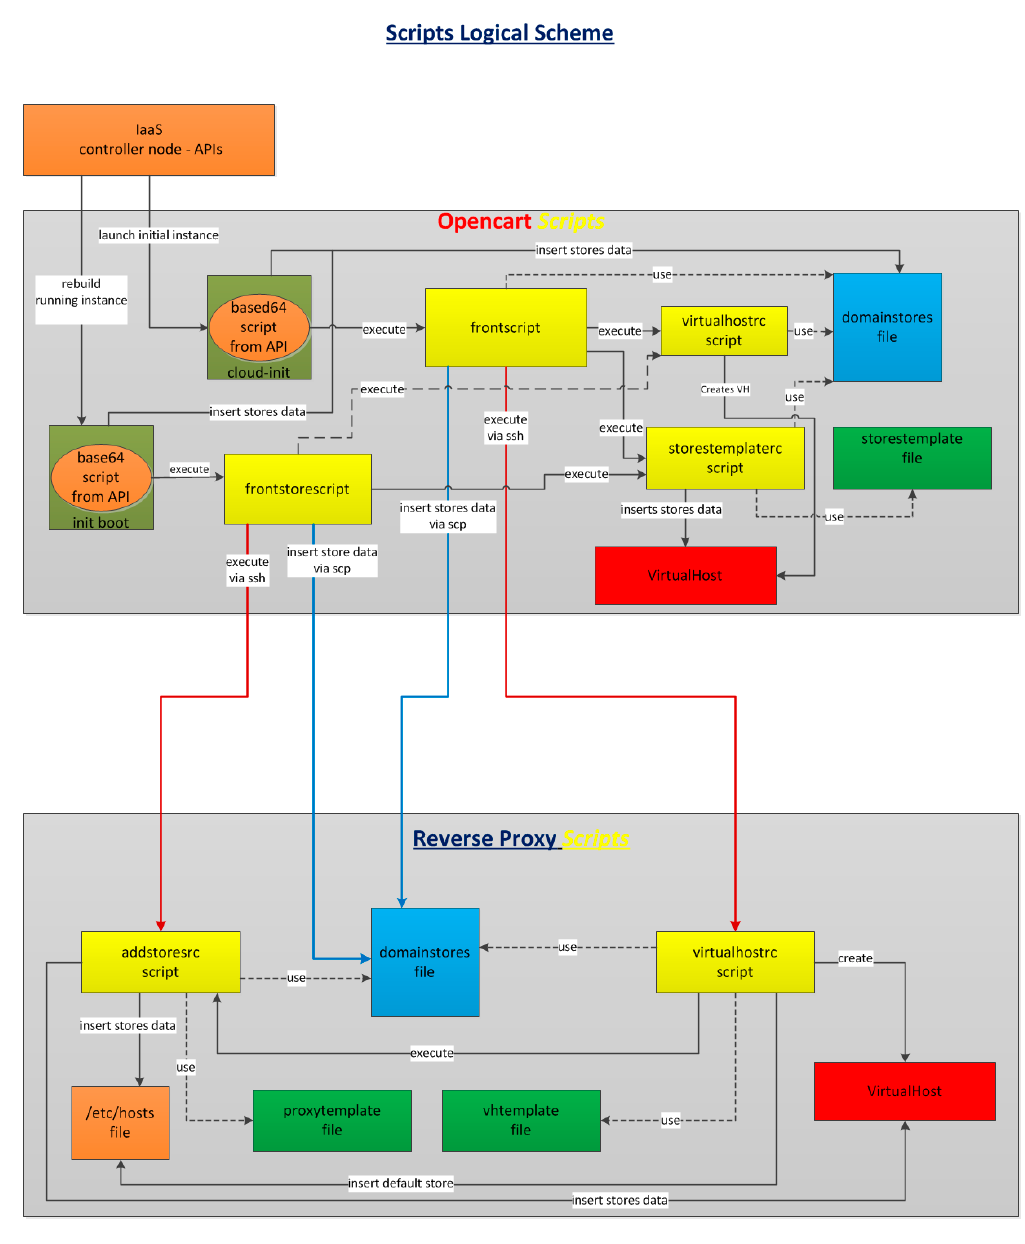
Figure 10. Scripts logical flow.